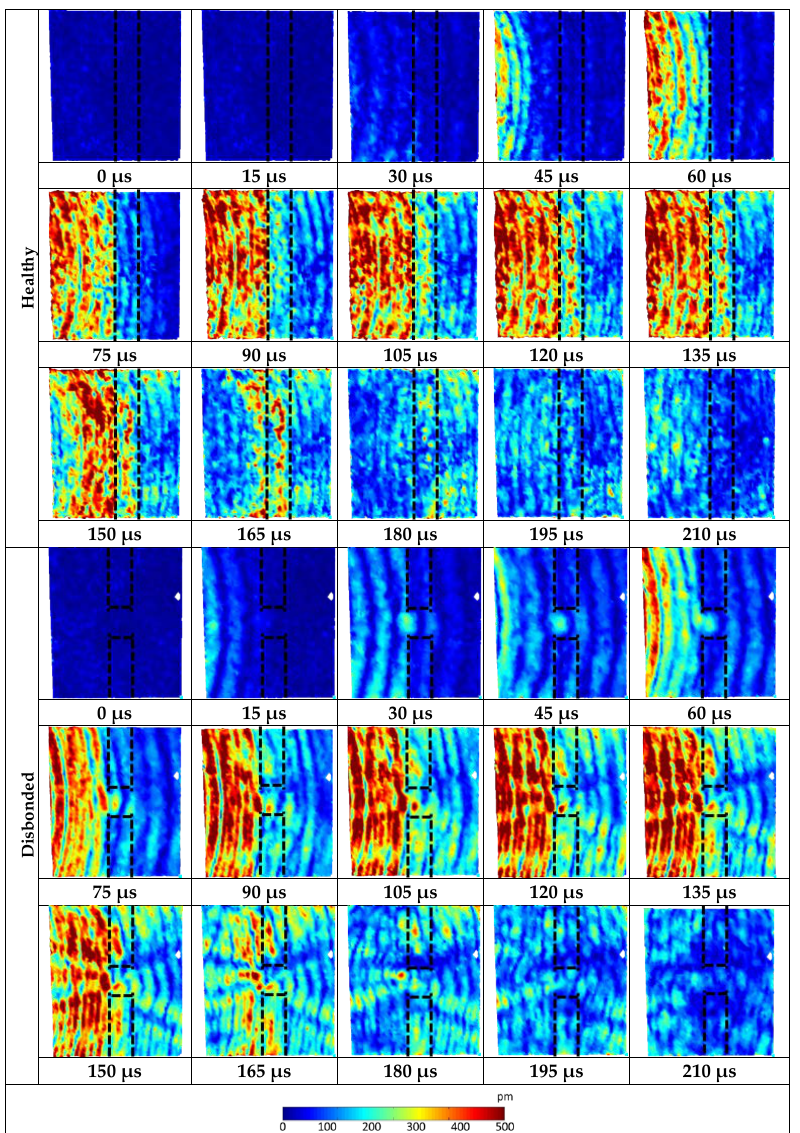
Figure 4. 100 kHz three-component displacement magnitude showing Lamb wave interaction with the healthy and disbonded stiffened panel.